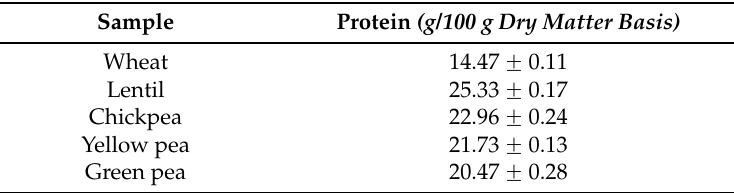
Table 2. Protein content of raw ingredients used.